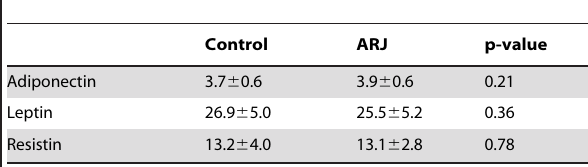
Table 1. Concentrations of glucose, insulin, cholesterol, NEFA, and triglycerides in serum of Fischer rats after 10 weeks of intervention with polyphenol-depleted grape-bilberry juice (control) or ARJ (n=24/group).